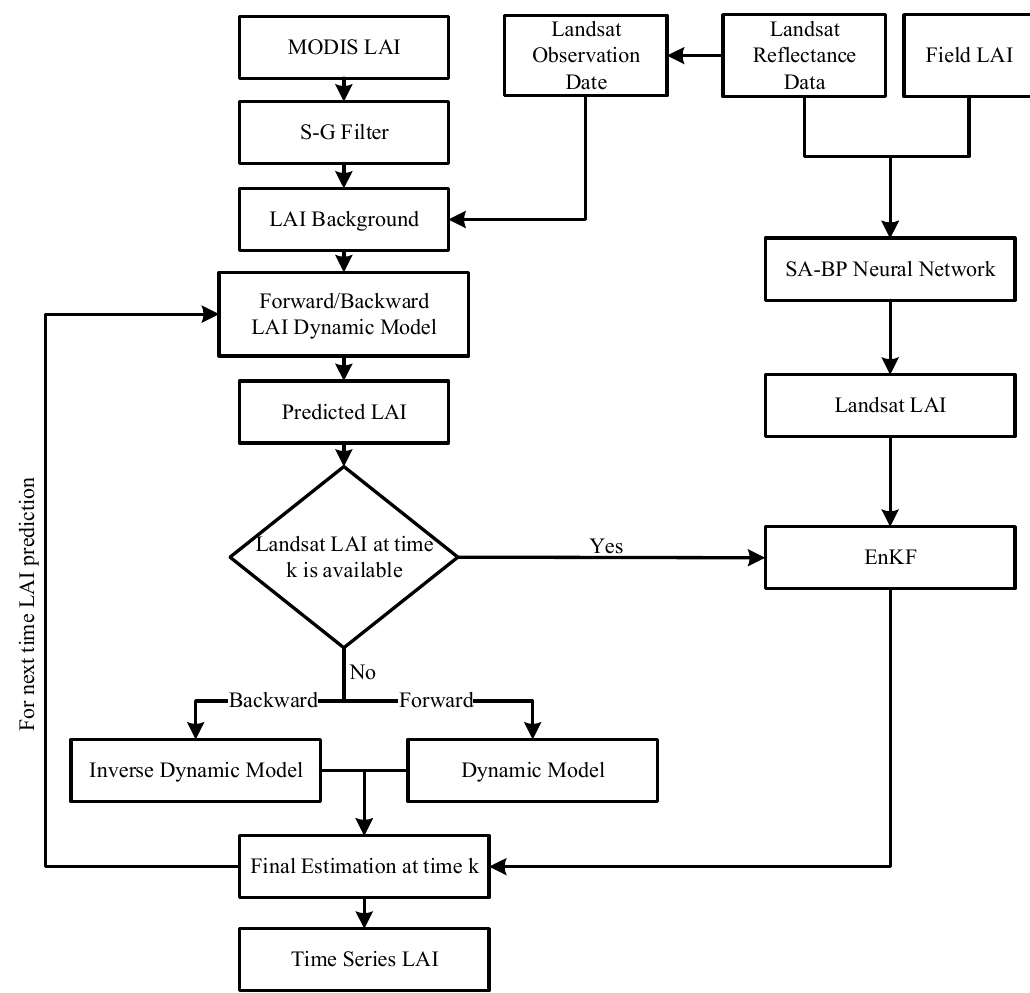
Figure 2. Modified ensemble Kalman filter model (MEnKF) algorithm flowchart.